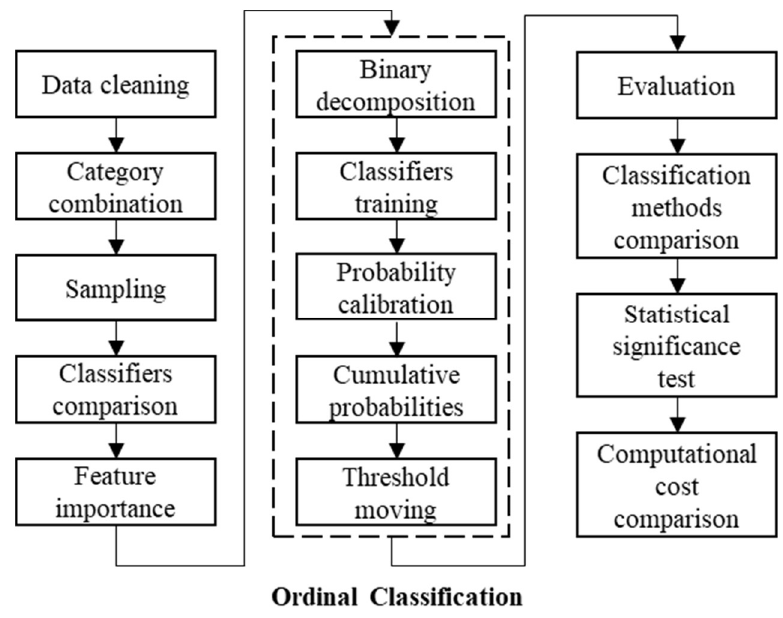
Figure 2. Research